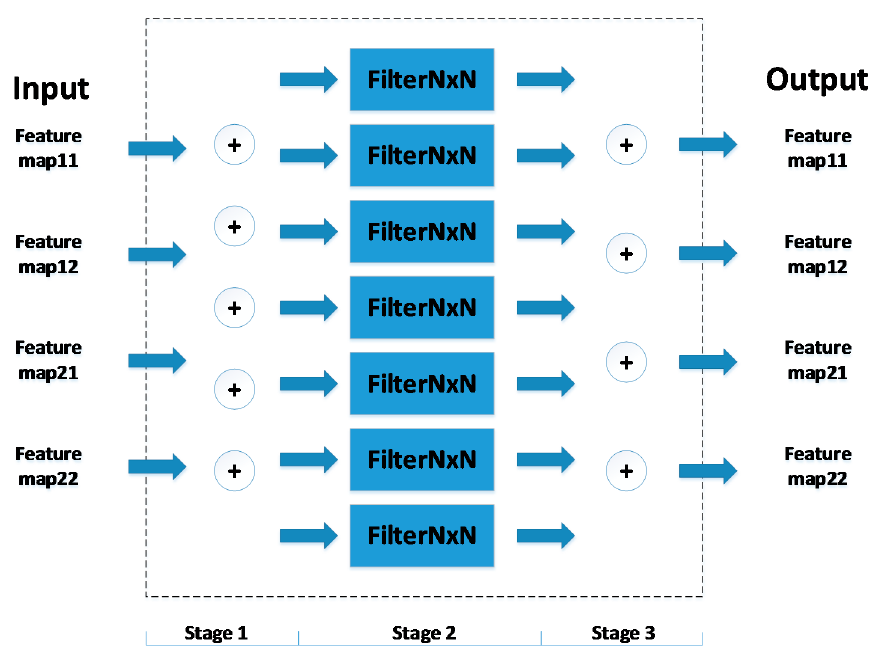
Figure 10. Architecture of the matrix convolution based on the Strassen–Winograd algorithm.